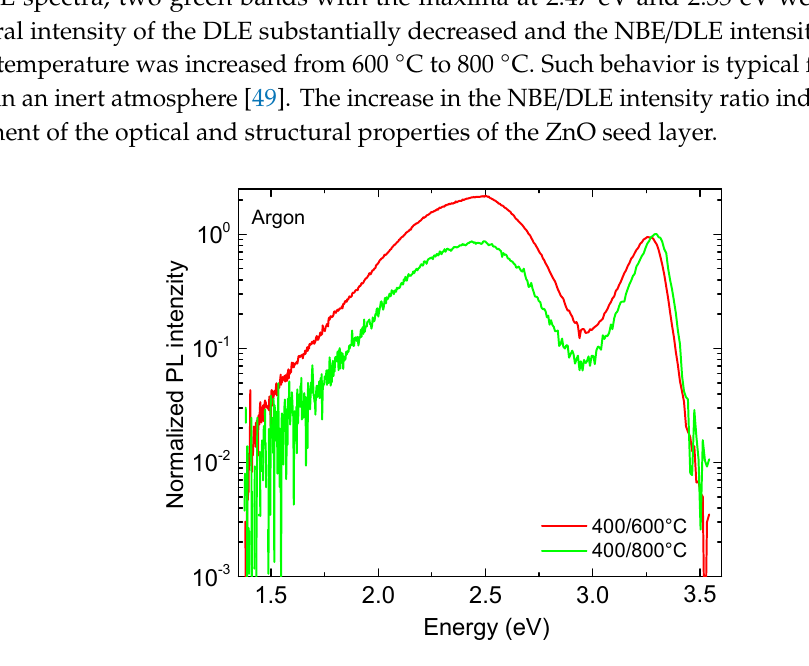
Figure 8. Room temperature photoluminescence spectra of the seed layer preheated and annealed in argon at different temperatures: red line 400 °C/600 °C; green line 400 °C/800 °C.